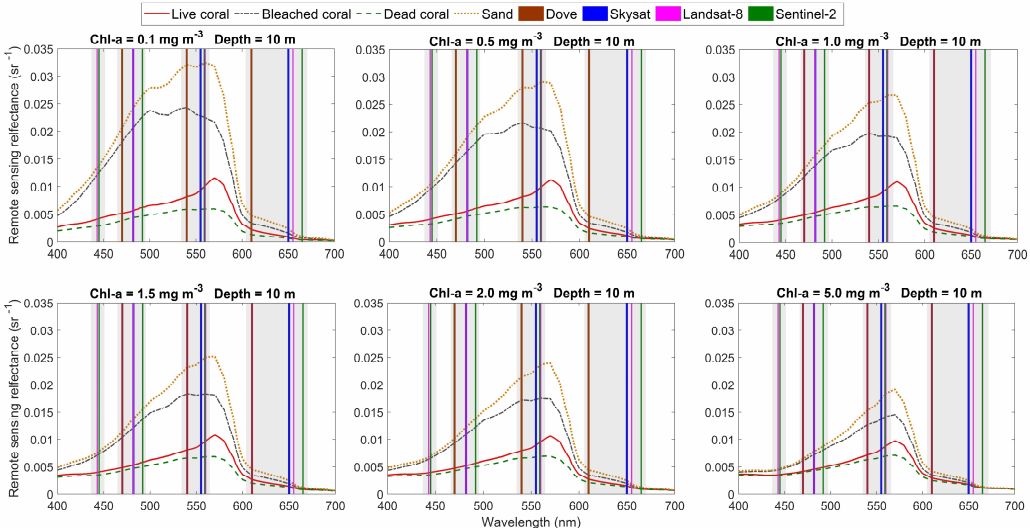
Figure 2. Model-generated remote sensing reflectance at different chlorophyll-a concentrations with constant depth.